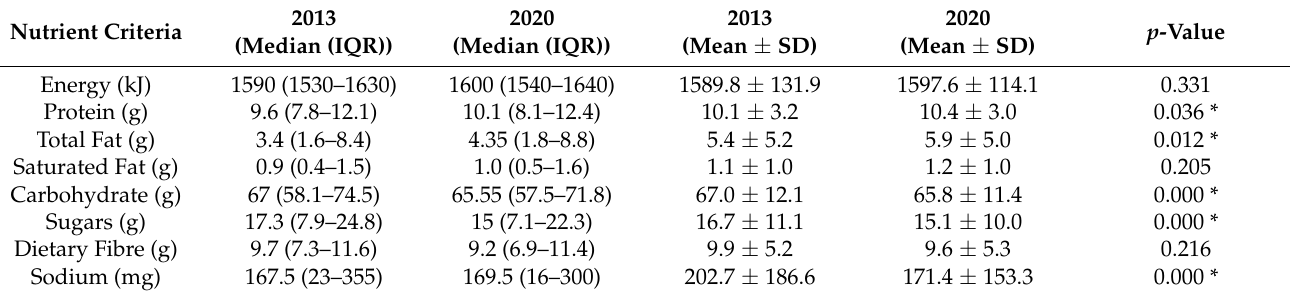
Table 4. Comparison of nutrient content per 100 g for breakfast cereals marketed under the same name in 2013 and 2020 ( n = 134), stratified by year of data